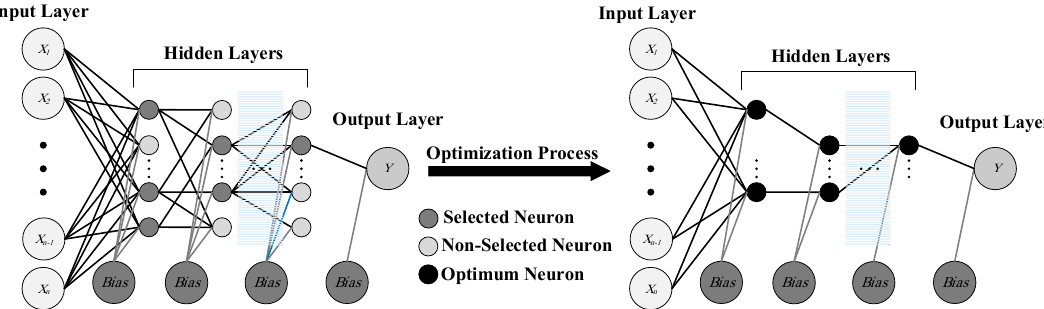
Figure 5. Schematic of GMDH-NN algorithm.